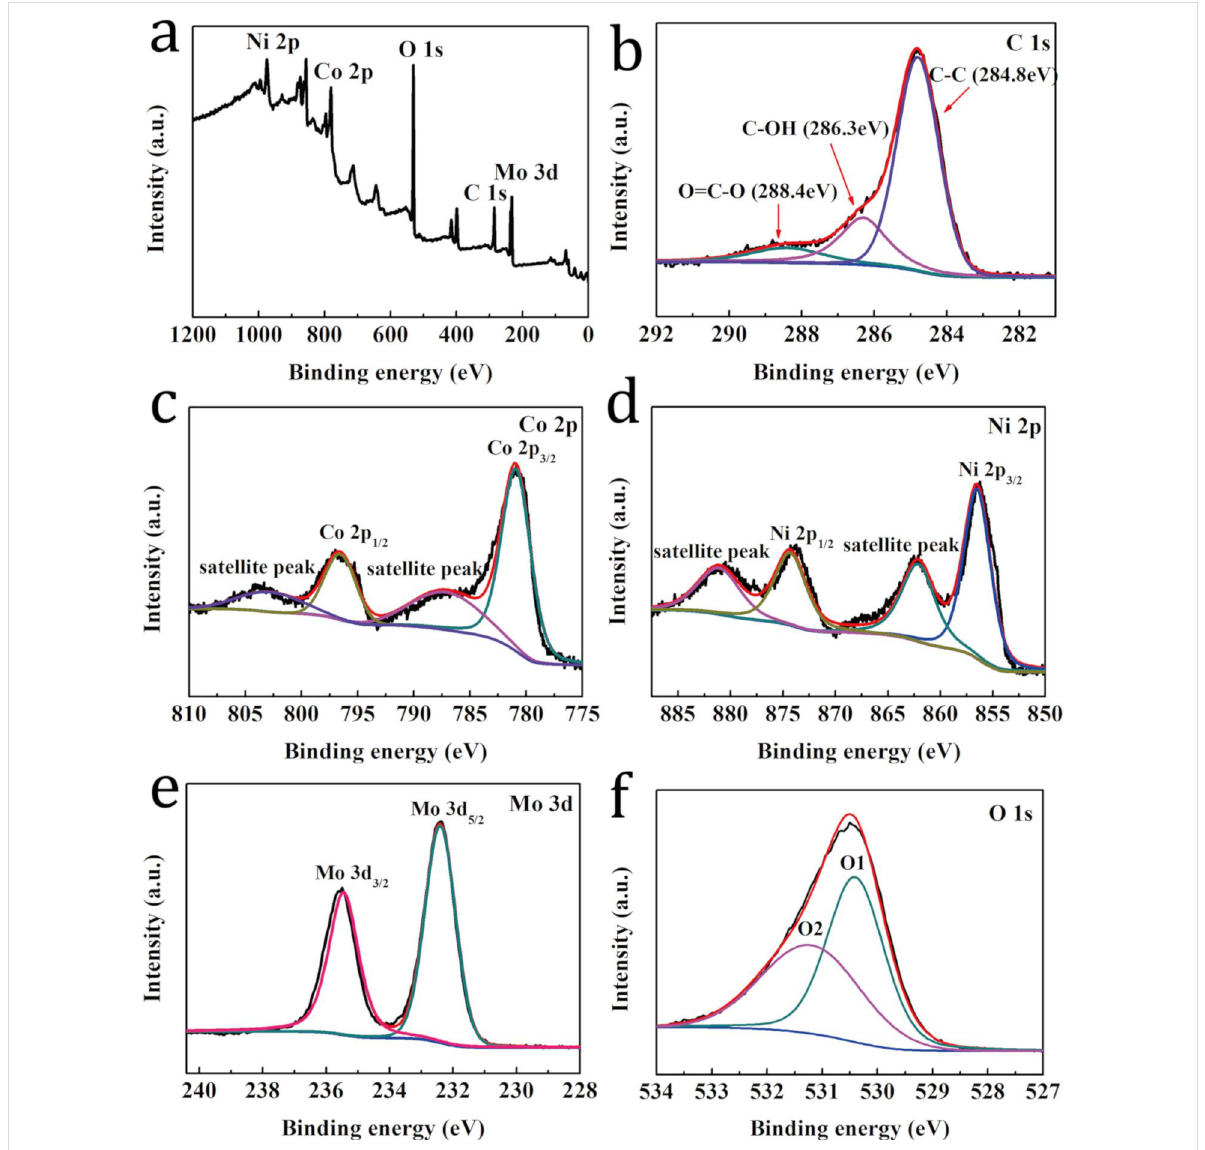
Figure 4: XPS spectra of the NiMoO 4 @Co 3 O 4 /CA composite: (a) Survey spectrum; (b-f) Core-level spectra of (b) C 1s, (c) Co 2p, (d) Ni 2p, (e) Mo 3d and (f) O